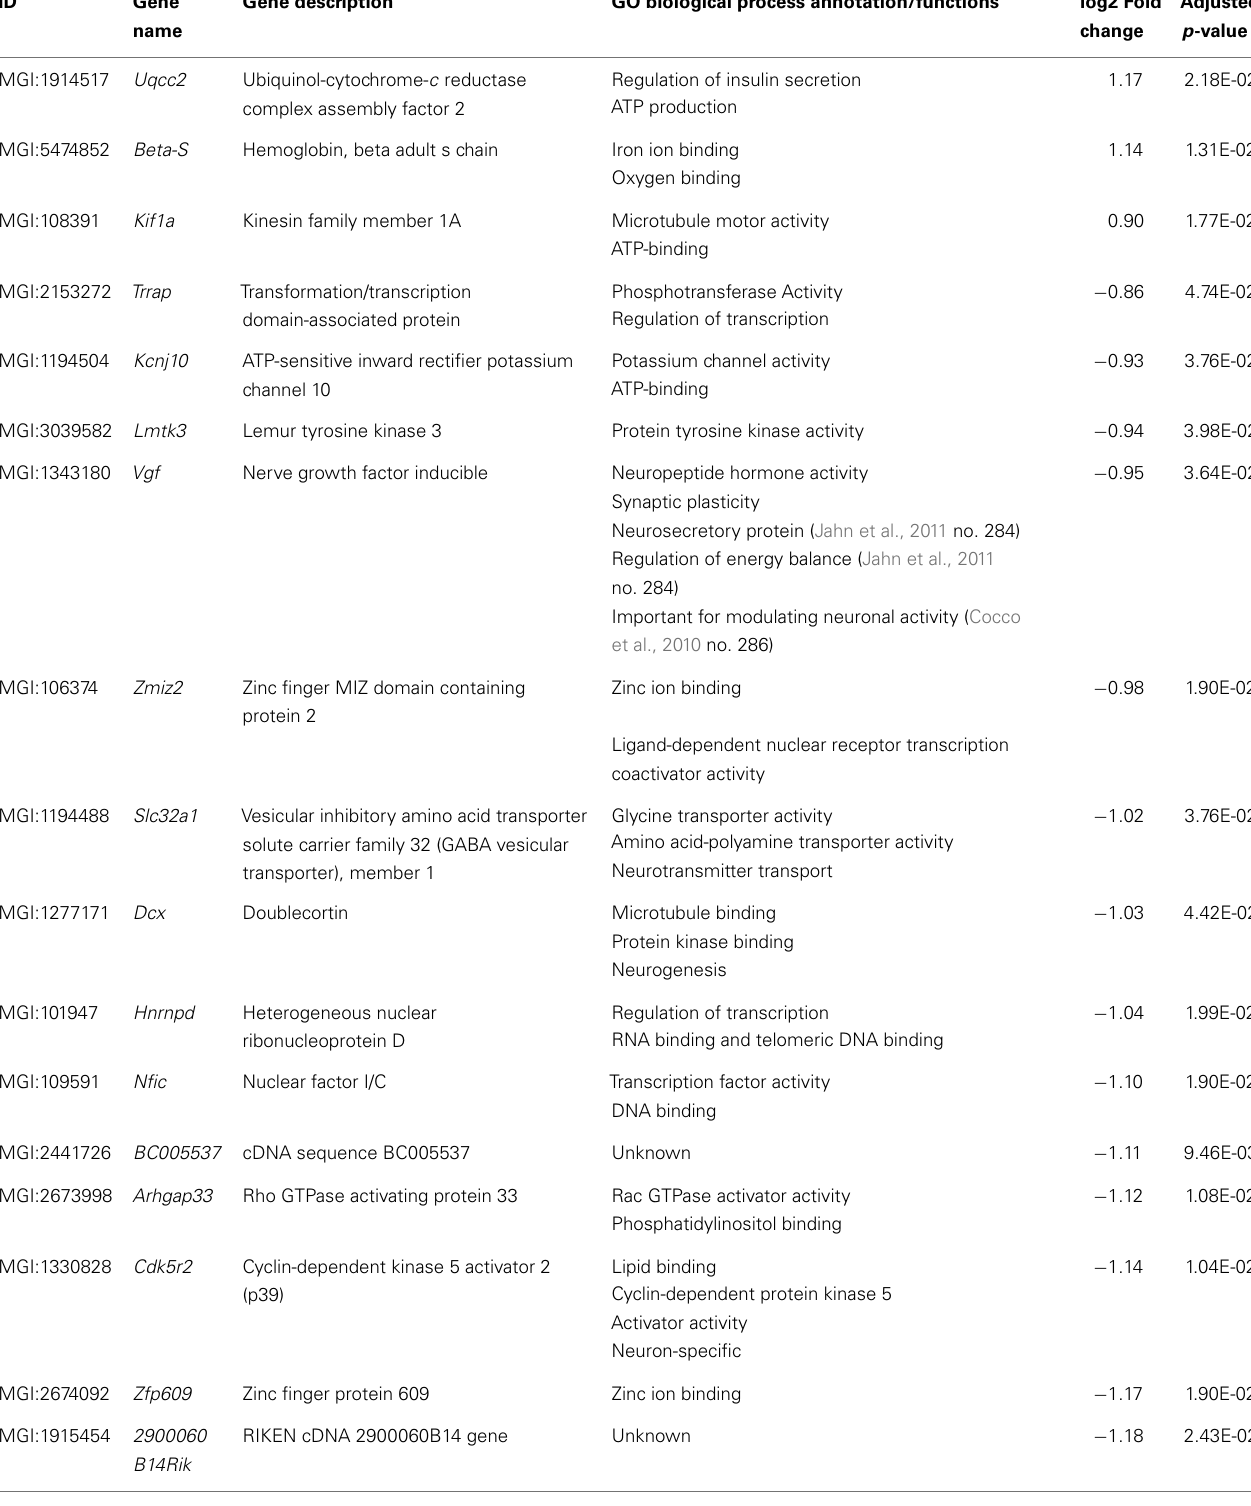
Table 3 | List of transcripts exclusively differentially expressed in